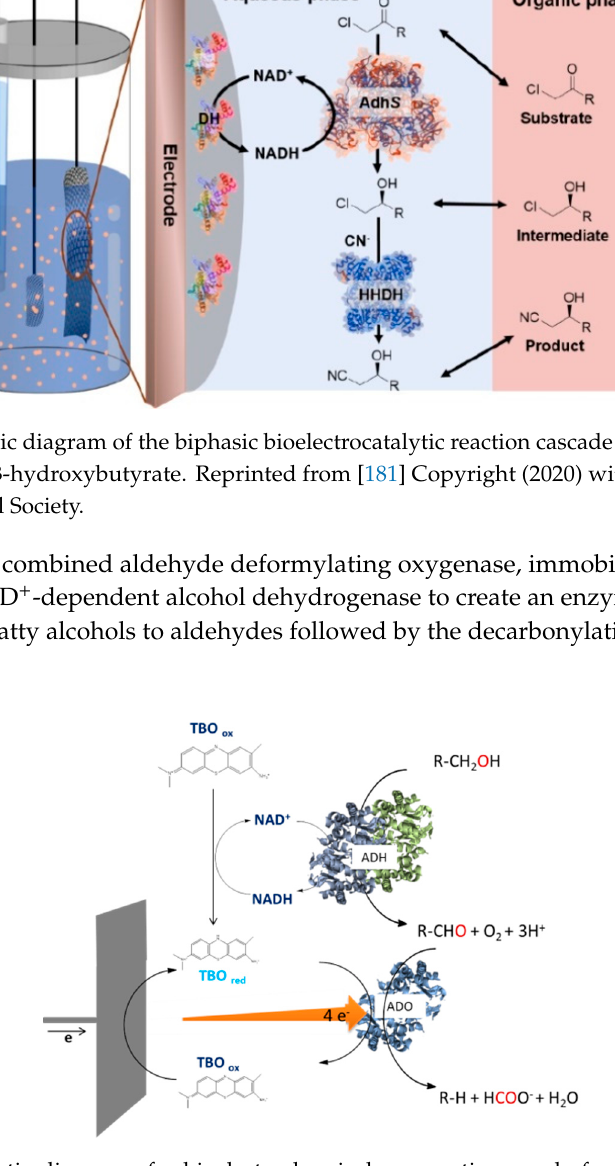
Figure 14. Schematic diagram of the light-assisted synthesis of methanol from CO 2 via an enzyme cascade (formaldehyde dehydrogenase, formate dehydrogenase, and alcohol dehydrogenase) [183] . Chen et al. developed an enzyme cascade to produce chiral amines from nitrogen. NH 3 was produced from N 2 via nitrogenase and then used, with L-alanine dehydrogenase, to produce alanine from pyruvate. The desired chiral amines were produced via the ω -transaminase transfer of an amino group from alanine. Pyruvate was generated as a by-product and converted to alanine using L- alanine dehydrogenase. The system was used for the successful amination of the substrates, 4-phenyl- 2 butanone, 4-methyl methoxy phenyl acetone, phenoxyacetone, 2-pentanone, methoxyacetone and 2-octanone with an enantiomeric excess >99% (Figure 15) [52].